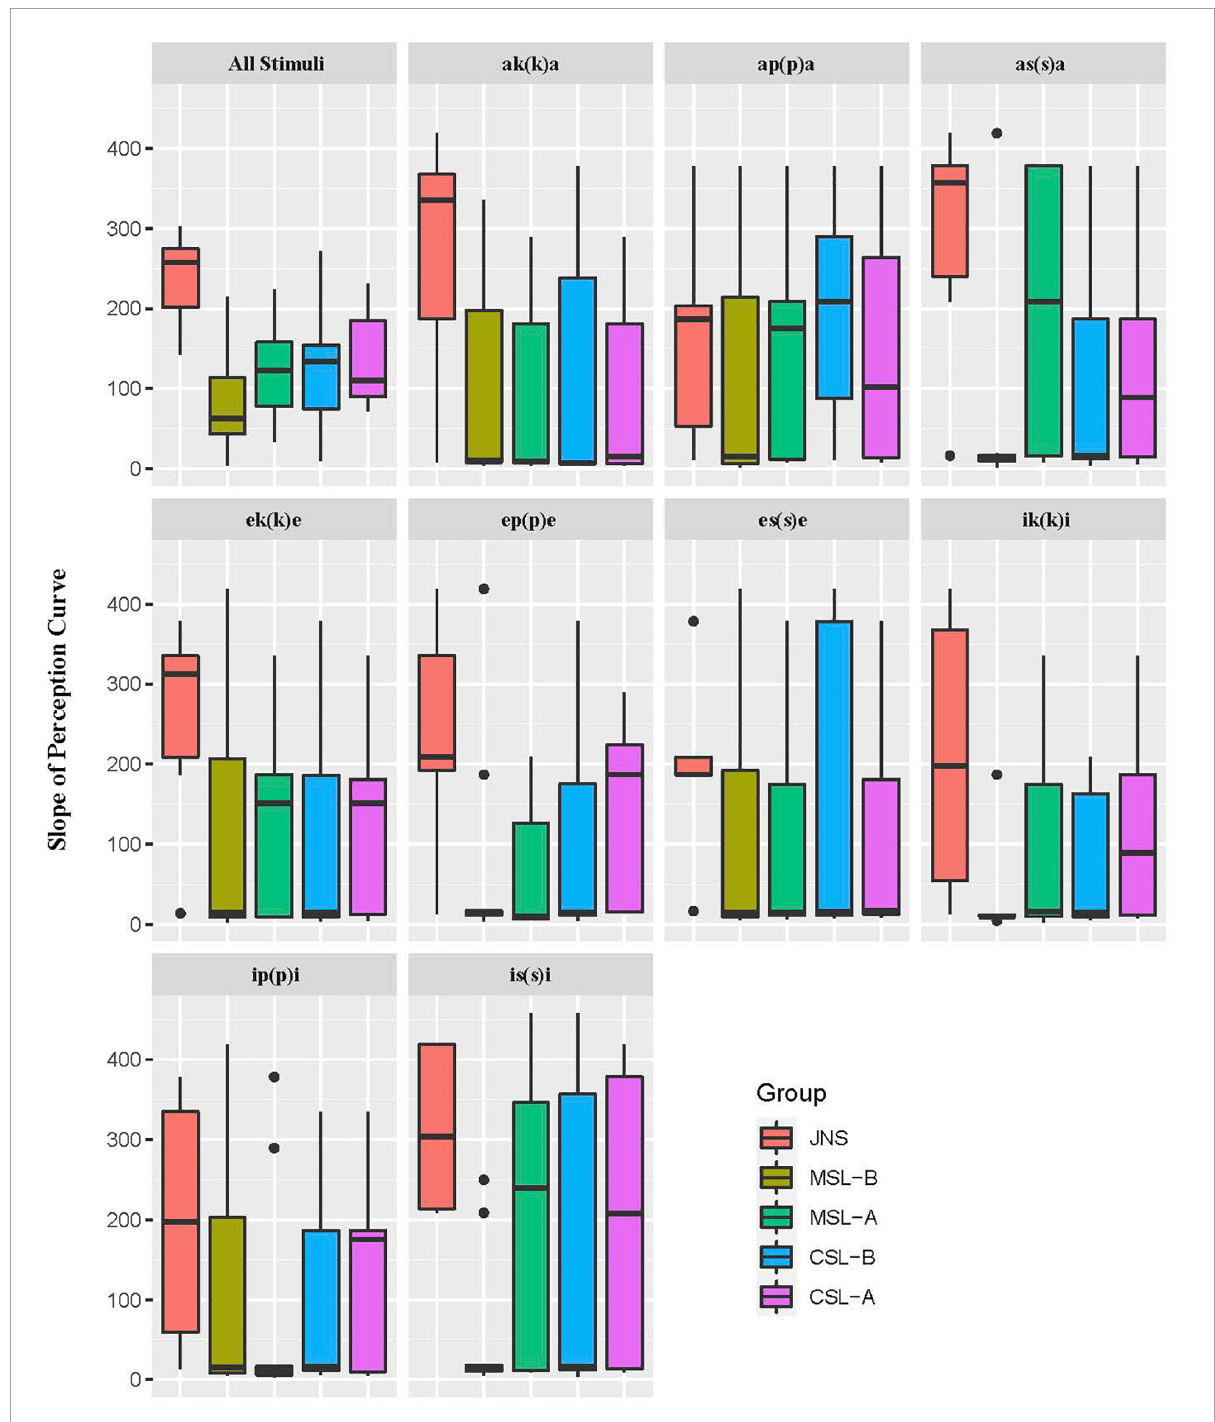
FIGURE3 Average values of slope of perception curve by five groups for all stimuli and for each minimal pair.